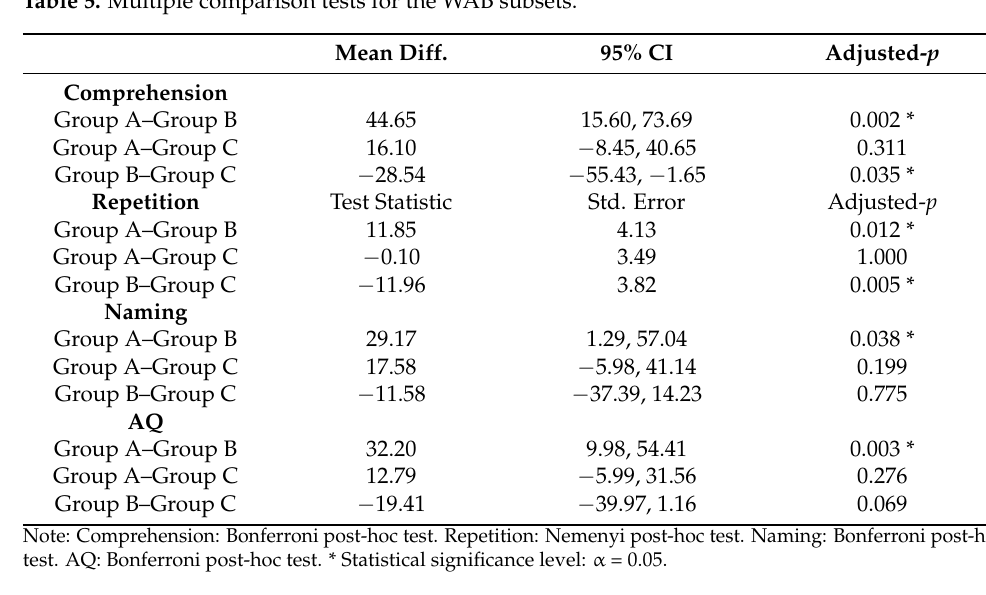
Table 5. Multiple comparison tests for the WAB subsets.